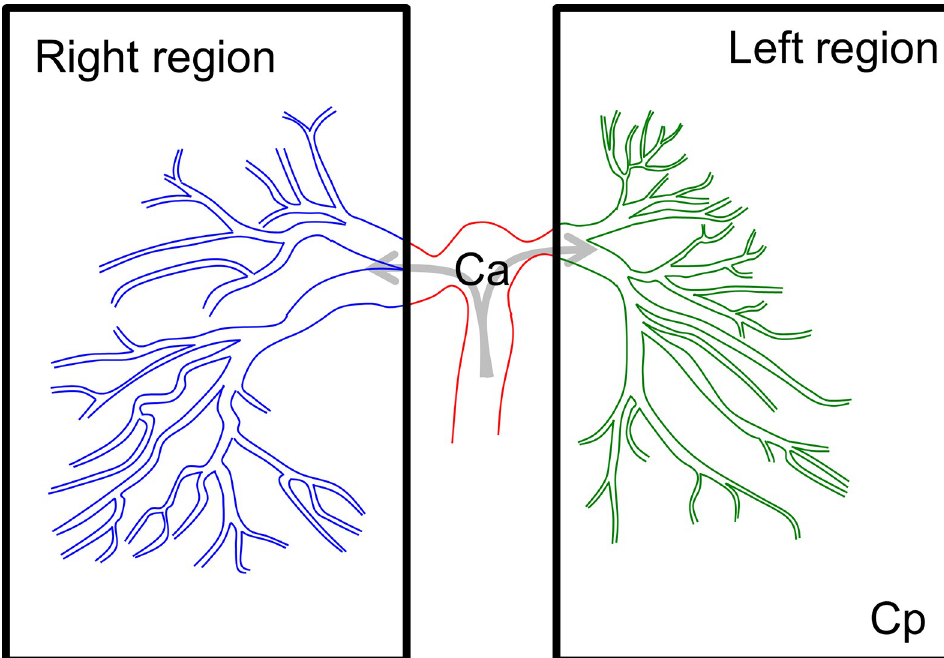
Fig 1. ROI establishment for the right and left lung regions. The region of interest (ROI) was set to cover the entire field of the right and left lung separately. Ca represents the tracer concentration in the main pulmonary trunk, and Cp represents the tracer concentration in each lung